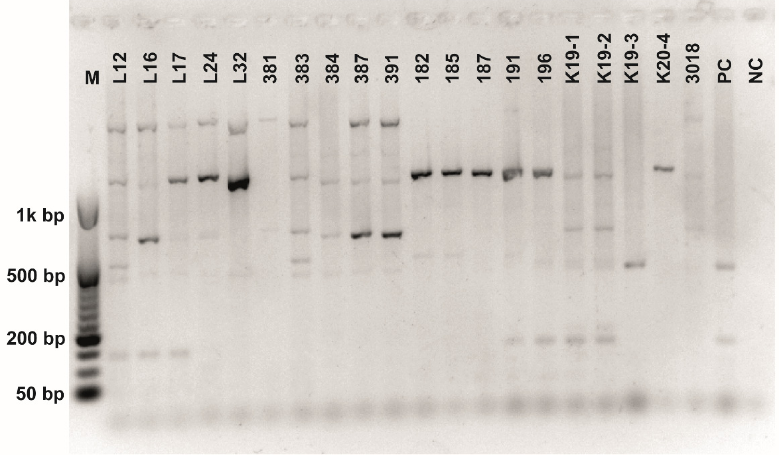
Figure A8. Class 2a bacteriocin gene belonging to the Clade 5 amplified using second primer pair (Table 3). O’RangeRuler TM 50 bp DNA Ladder was used as a molecular marker. PC-positive control by strain ATTCC 14917.